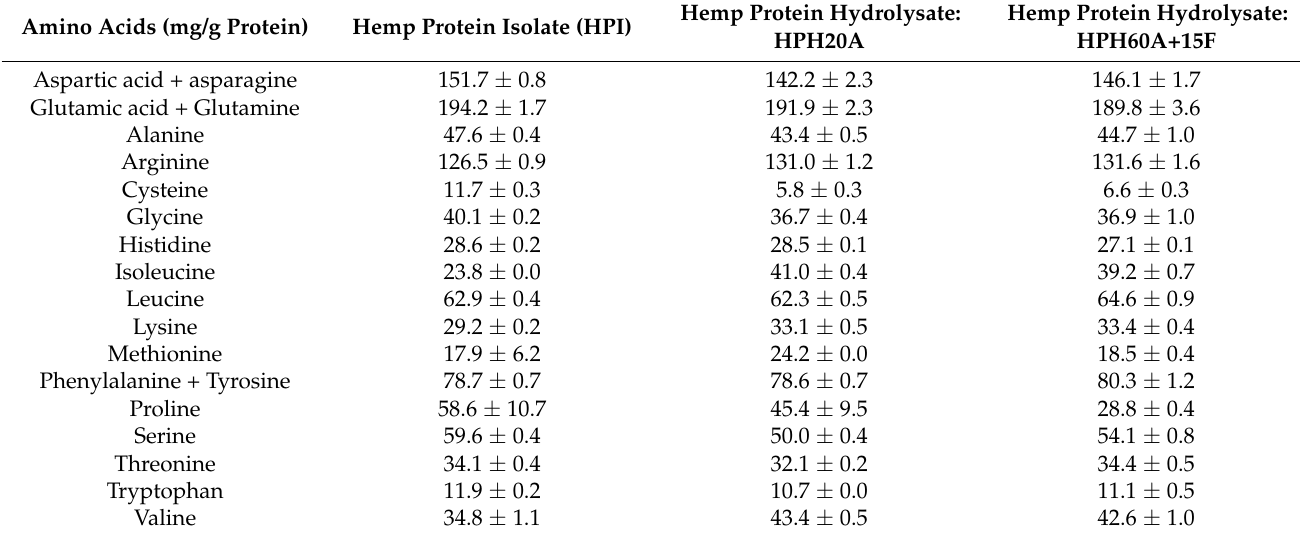
Table A2. Amino acid profile of defatted hemp flour (DHF), HPI, HPH20A, and HPH60A15F by HPLC. Values were expressed as milligrams of amino acids by grams of protein, are the mean ± standard deviation of